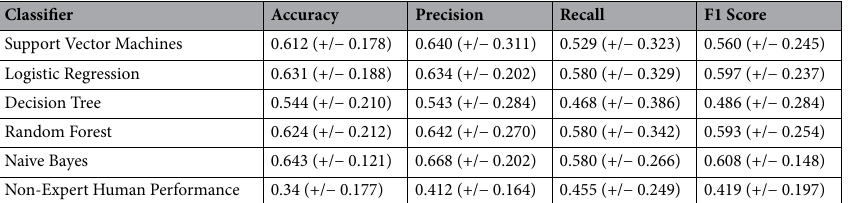
Table 1. Evaluation of the classification performance of the tool with original video data from the wet- bench experiments We used a cross-validation style test with 10 folds of classifications. This means that the classification experiment was run 10 times, varying the training and validation data. Each run used 90% of the data (144 videos) for training and 10% of the data (16 videos) for testing. Reported error is standard deviation.